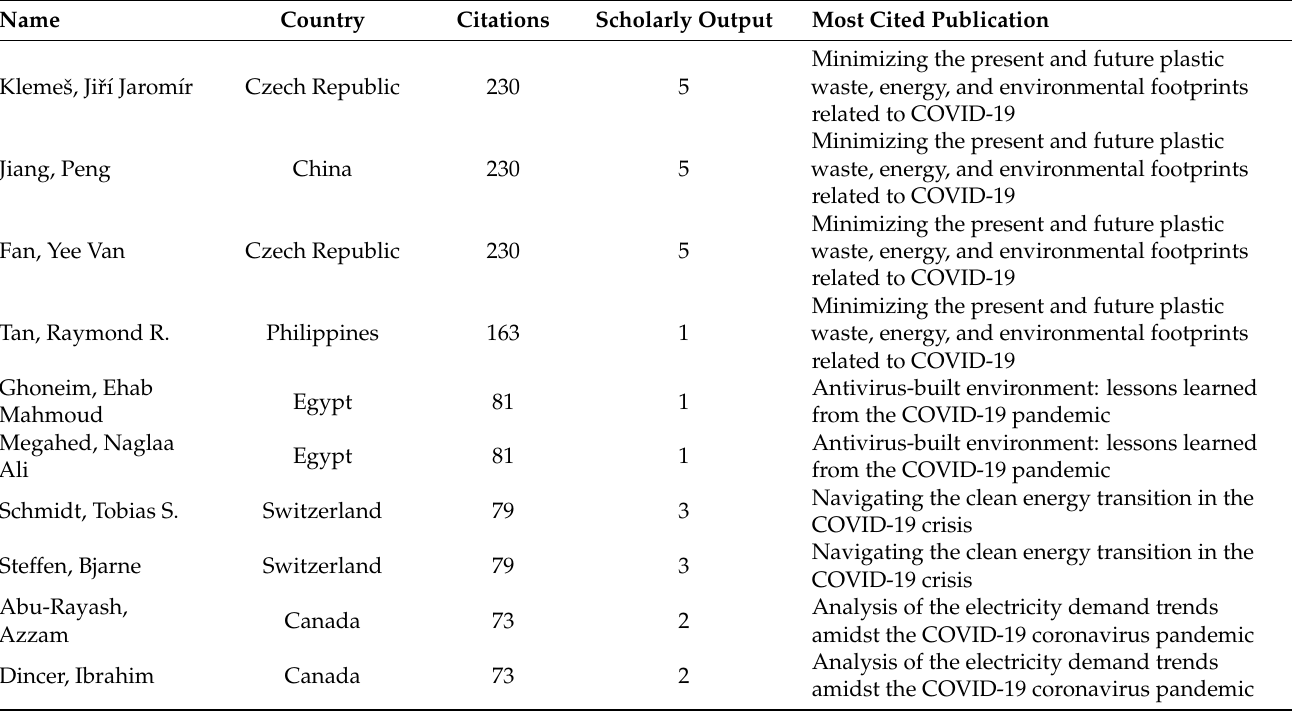
Table 4. Top 10 authors by the number of citations in Scopus within energy (subject area: renewable energy, sustainability, and the environment),